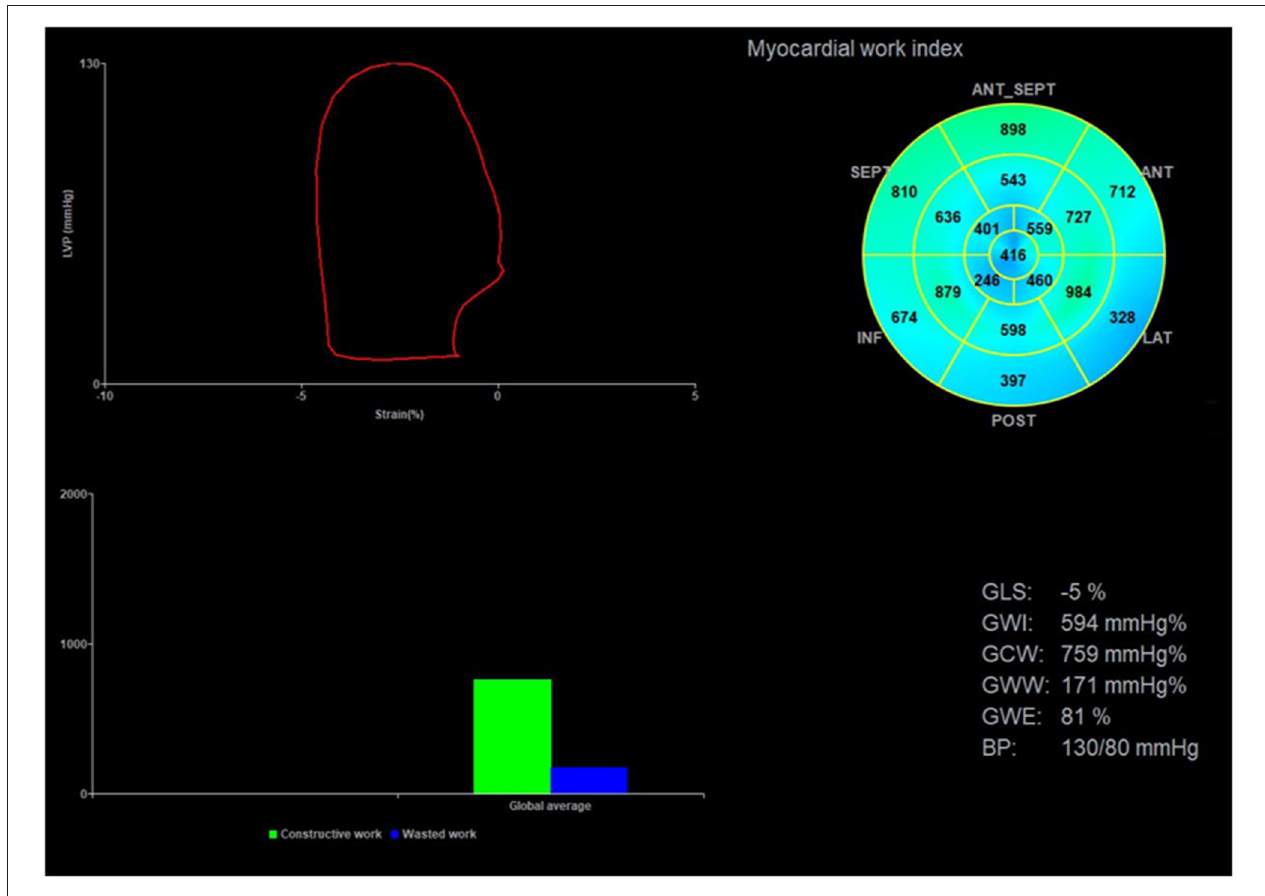
FIGURE 2 | Image analysis for myocardial work. The upper left corner of the image is the left ventricular PSL curve, the upper right corner is the 17-segment myocardial work index bull’s eye diagram, and the lower right corner displays the left ventricular global myocardial work indices obtained from the PSL curve. PSL, pressure-strain